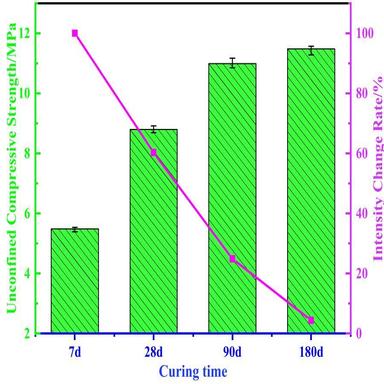
UCS of RFG-5 sample at different curing times.